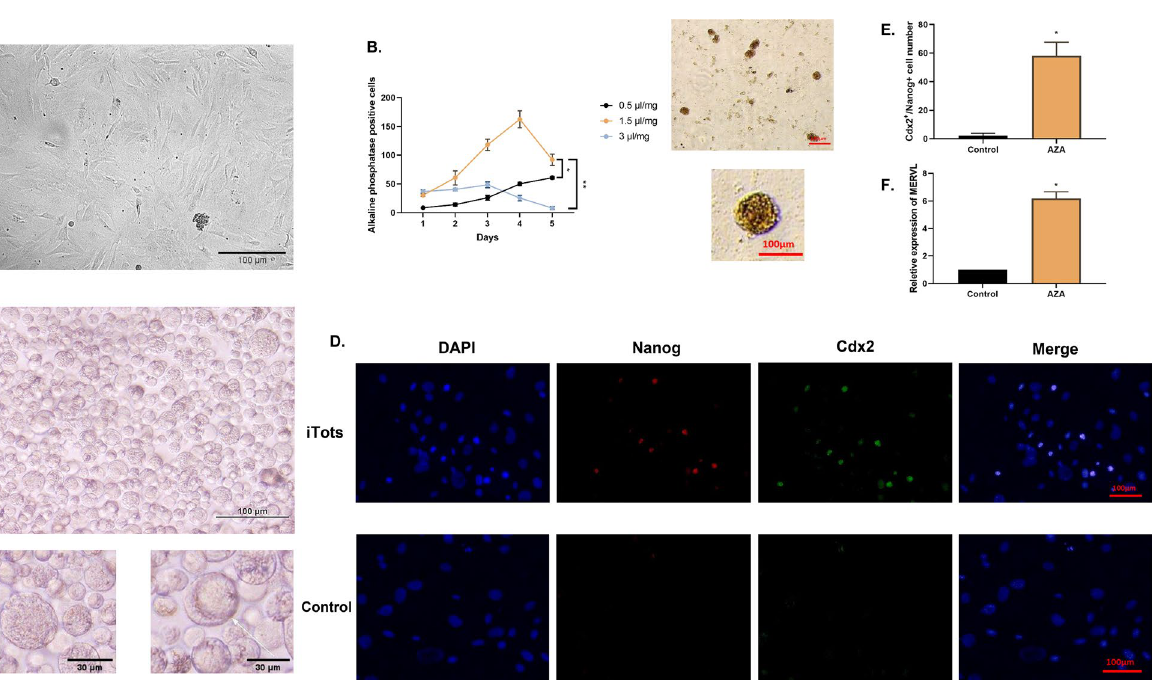
Figure 1. Induction of totipotent stem cells. ( A ) Fibroblast extraction is used as a source due to easy handling. ( B ) Aza could induce alkaline phosphatase positive cells (*P < 0.05, **P < 0.01). ( C ) Induced cells after sorting show significant morphologies. ( D ) Aza administration on fibroblast cells leads to Nanog and Cdx2-positive cells. ( E ) Number of Nanog and Cdx2 positive cells are significantly higher in Aza-treated cells in their absence in the control group (*P < 0.05). ( F ) MERVL induced in AZA-treated cells versus untreated cells (*P <